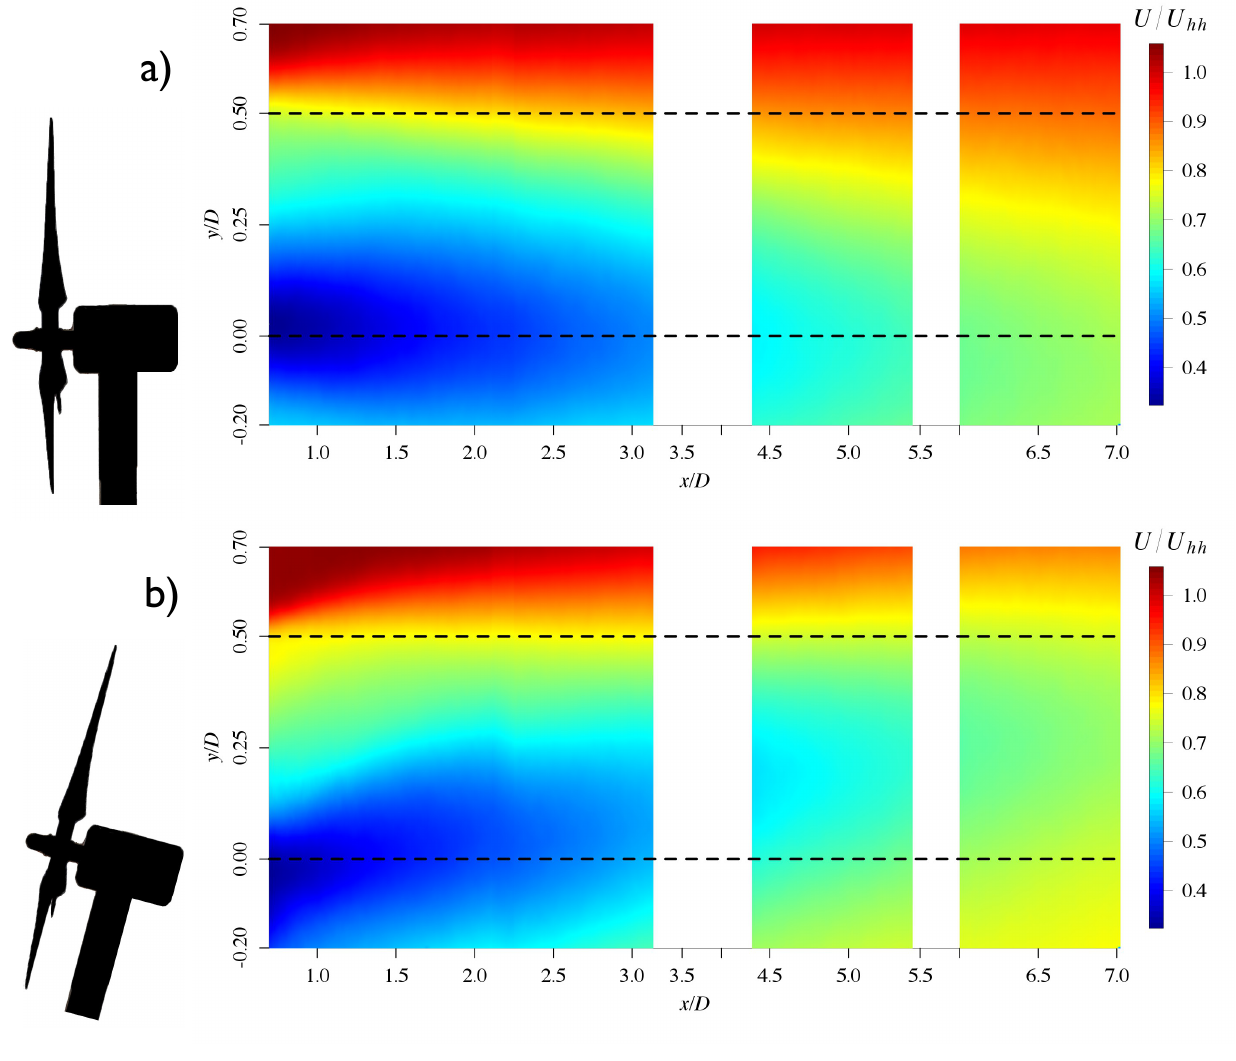
Figure 3. Normalized streamwise velocity component U / U of the wake for the fixed and hh floating cases. U/U in the fixed case has a typical symmetric shape around hub height. hh In the floating case it has a pronounced upwards trend with increasing x/D . Hub height ( y/D = 0) and top blade tip ( y/D = 0.5) are indicated by dashed horizontal